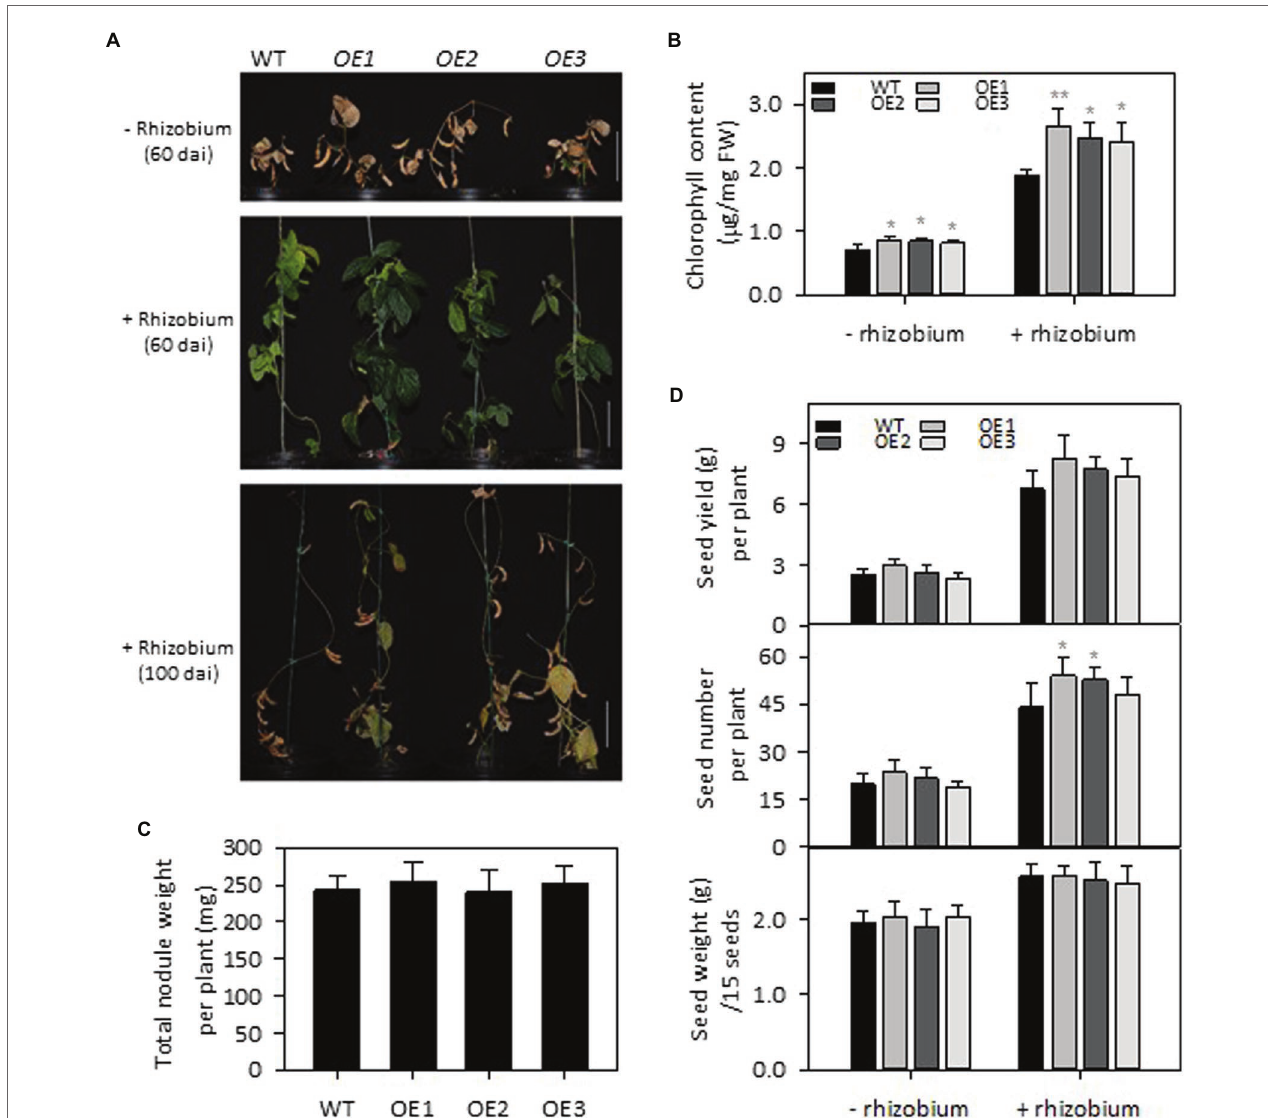
FIGURE 3 | Effects of PLD ε alterations on seed yield under nitrogen deficiency with or without nodulation. (A) Morphology of WT and AtPLD ε OE soybean plants under nitrogen-deficient conditions 60 or 100 days after infection (dai) with Bradyrhizobium diazoefficiens USDA110. Three-week-old soybeans grown on vermiculite supplied with 0.6 mM N were infected with Bradyrhizobium diazoefficiens USDA110. Scale bar = 10 cm. (B) Chlorophyll content of leaves from WT and AtPLD ε OE soybean plants under nitrogen-deficient conditions 28 days after infection. The values are means ± SD of five biological replicates. *Denotes statistical significance at p < 0.05 and **denotes statistical significance at p < 0.001 compared with WT as determined by one-way ANOVA (Duncan’s multiple range test). (C) Total nodule weight collected at 28 days after infection ( n = 5). (D) Seed yield: total seed number: and 15-seed weight ( n = 6). *Denotes statistical significance at p < 0.05 compared with WT as determined by one-way ANOVA (Duncan’s multiple range